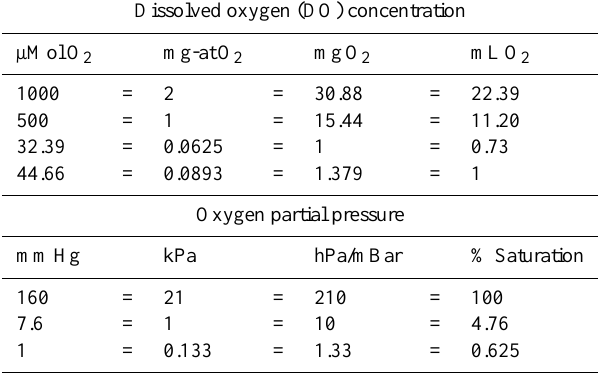
Table 1. Conversion factors between different units of dissolved oxygen (DO) concentrations and pressures (IAPSO, 1985; Grashoff et al.,